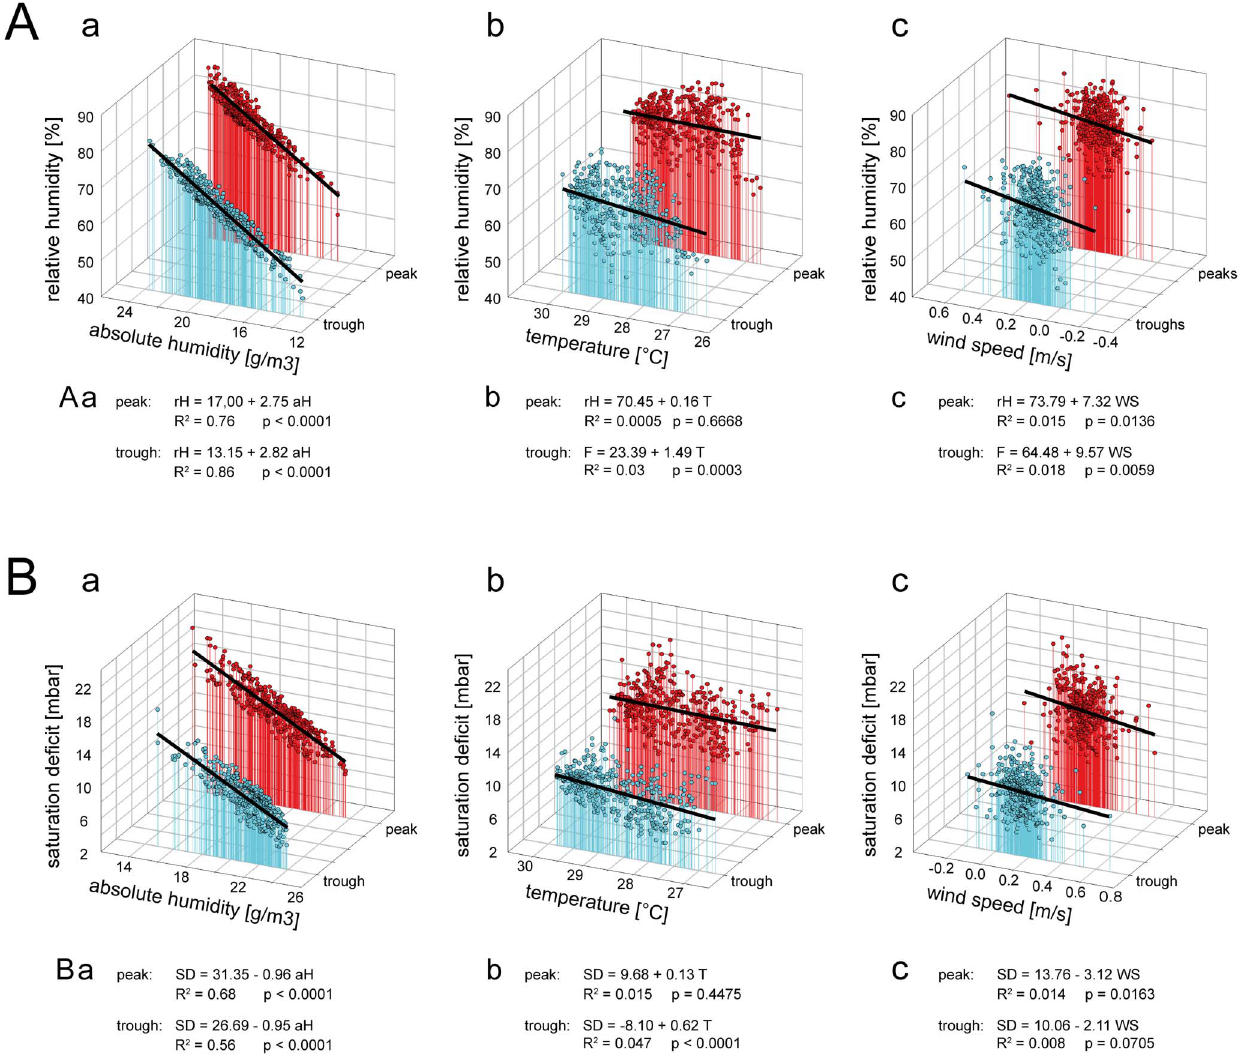
Figure 9. Relationships between humidity fluctuation values, temperature and wind speed. A . Peak and trough values of relative humidity plotted as functions of absolute humidity ( a ), temperature ( b ) and wind speed ( c ). B . Peak and trough values of saturation deficit plotted as functions of absolute humidity ( a ), temperature ( b ) and wind speed. Functions approximated by linear regressions. aH absolute humidity, R 2 coefficient for determination, rH relative humidity, SD saturation deficit, T temperature, WS wind